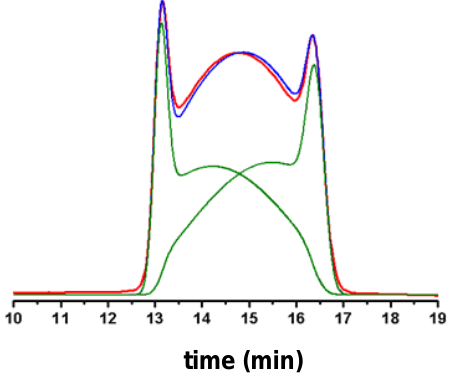
Figure 5. Computer-simulation of experimental deformed profiles of two interconverting species. Red line: experimental profile. Blue line: computer-simulated profile. Green lines: computer-simulated profiles of the individual interconverting